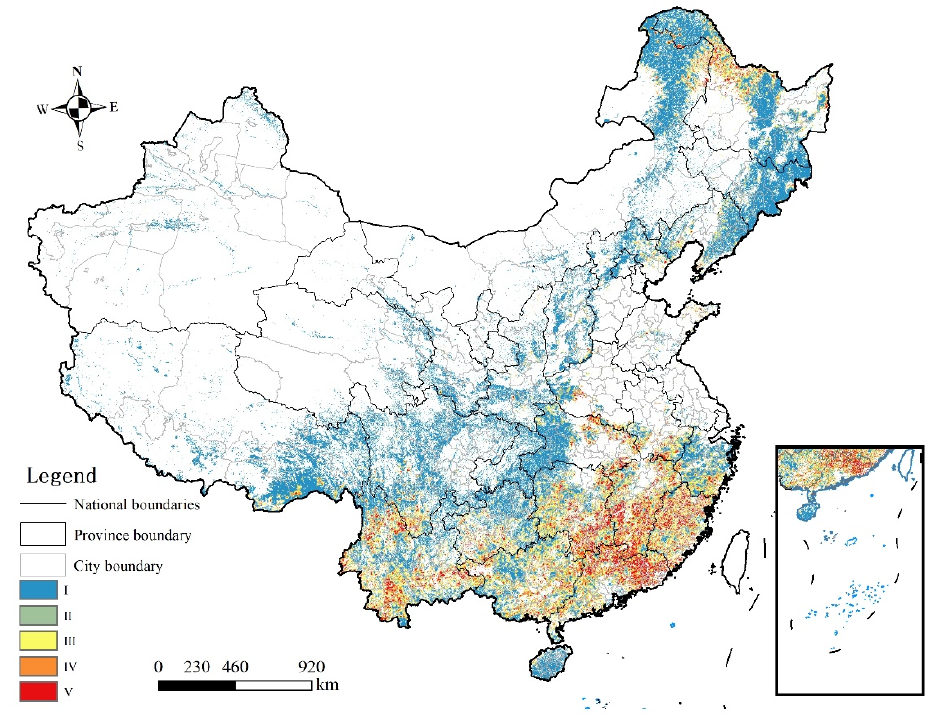
Figure 8. Forest fire zoning in China (Classes I/II/III/IV/V indicate very low, low, medium, high, and very high probability, respectively).